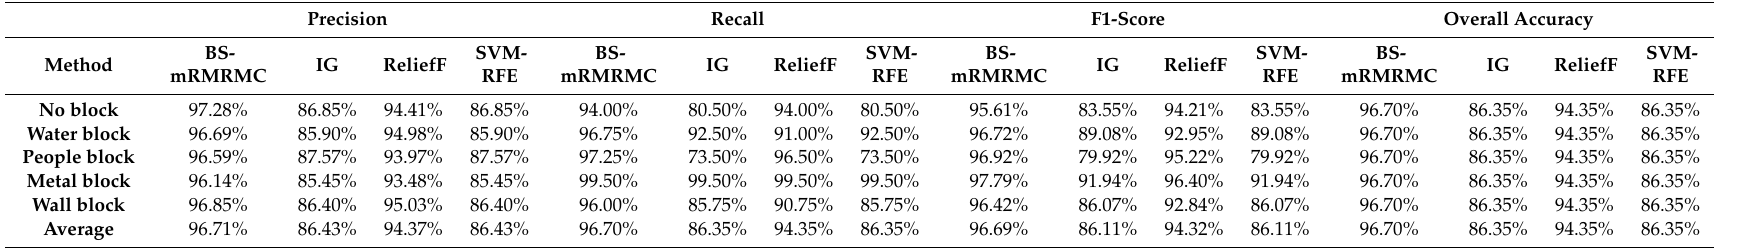
Table 3. The identification indexes of various categories are compared under the four